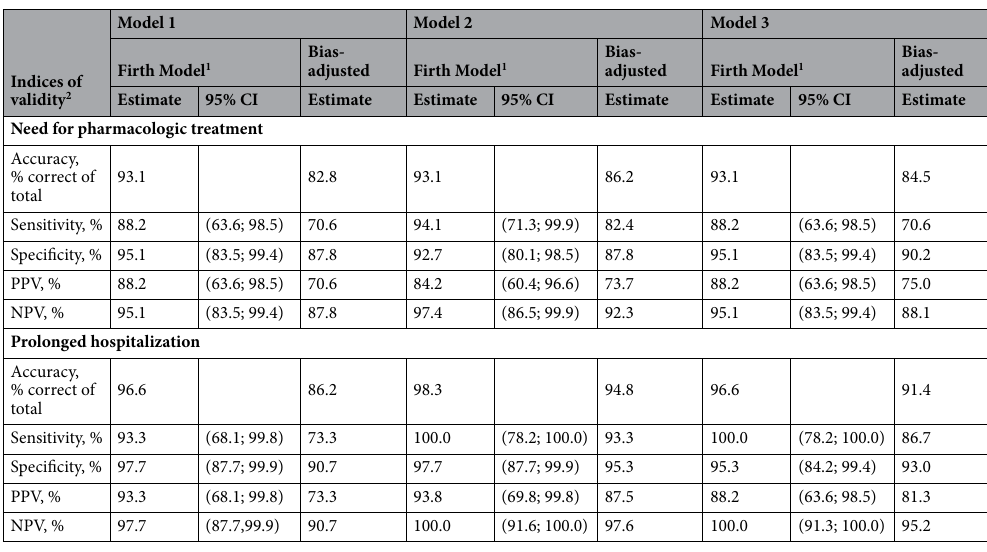
Table 5. Predictive validity of the miRNA signature a for identification of infants with NOWS requiring pharmacologic treatment or prolonged hospitalization. Model 1 includes signature miRNAs. Model 2 includes signature miRNAs and gestational age. Model 3 includes signature miRNAs, gestational age, and the type maternal MOUD. CI confidence interval, MOUD medication for opioid use disorder, NPV negative predictive value, PPV positive predictive value. a Includes let-7d-5p, miR-128-3p, miR-30c-5p, miR-421, miR-584-5p for need for pharmacologic treatment and let-7b-5p, miR-10b-5p, miR-128-3p, miR-30c-5p, and miR-421 for prolonged hospitalization. For prolonged hospitalization, miR-10b-5p was dropped from Model 2 and miR-10b-5p, let-7b-5p, and miR-128-3p were dropped from Model 3 due to lack of convergence. 1 Maximum likelihood estimates adjusted for small sample size using Firth’s penalized likelihood approach. 2 Based on using prediction probability point specified for each model (pharmacological treatment: Models 1 and 2: ≥ 0.46, Model 3: ≥ 0.60; prolonged hospitalization: Model 1: ≥ 0.55, Model 2: ≥ 0.45, Model 3: ≥ 0.40).